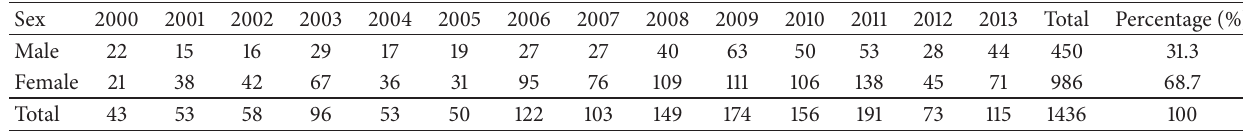
Table 1: Table showing the sex and yearly distribution for cancer mortality.